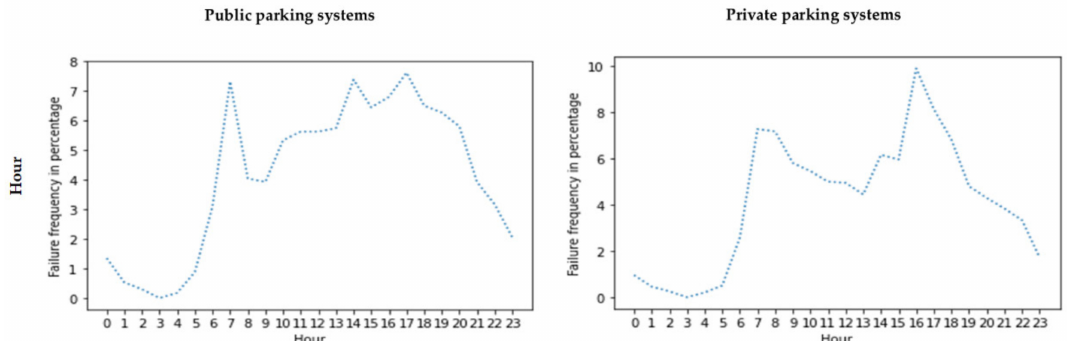
Figure 12. The month of the year for all failure events in public ( left ) and private ( right ) parking systems.